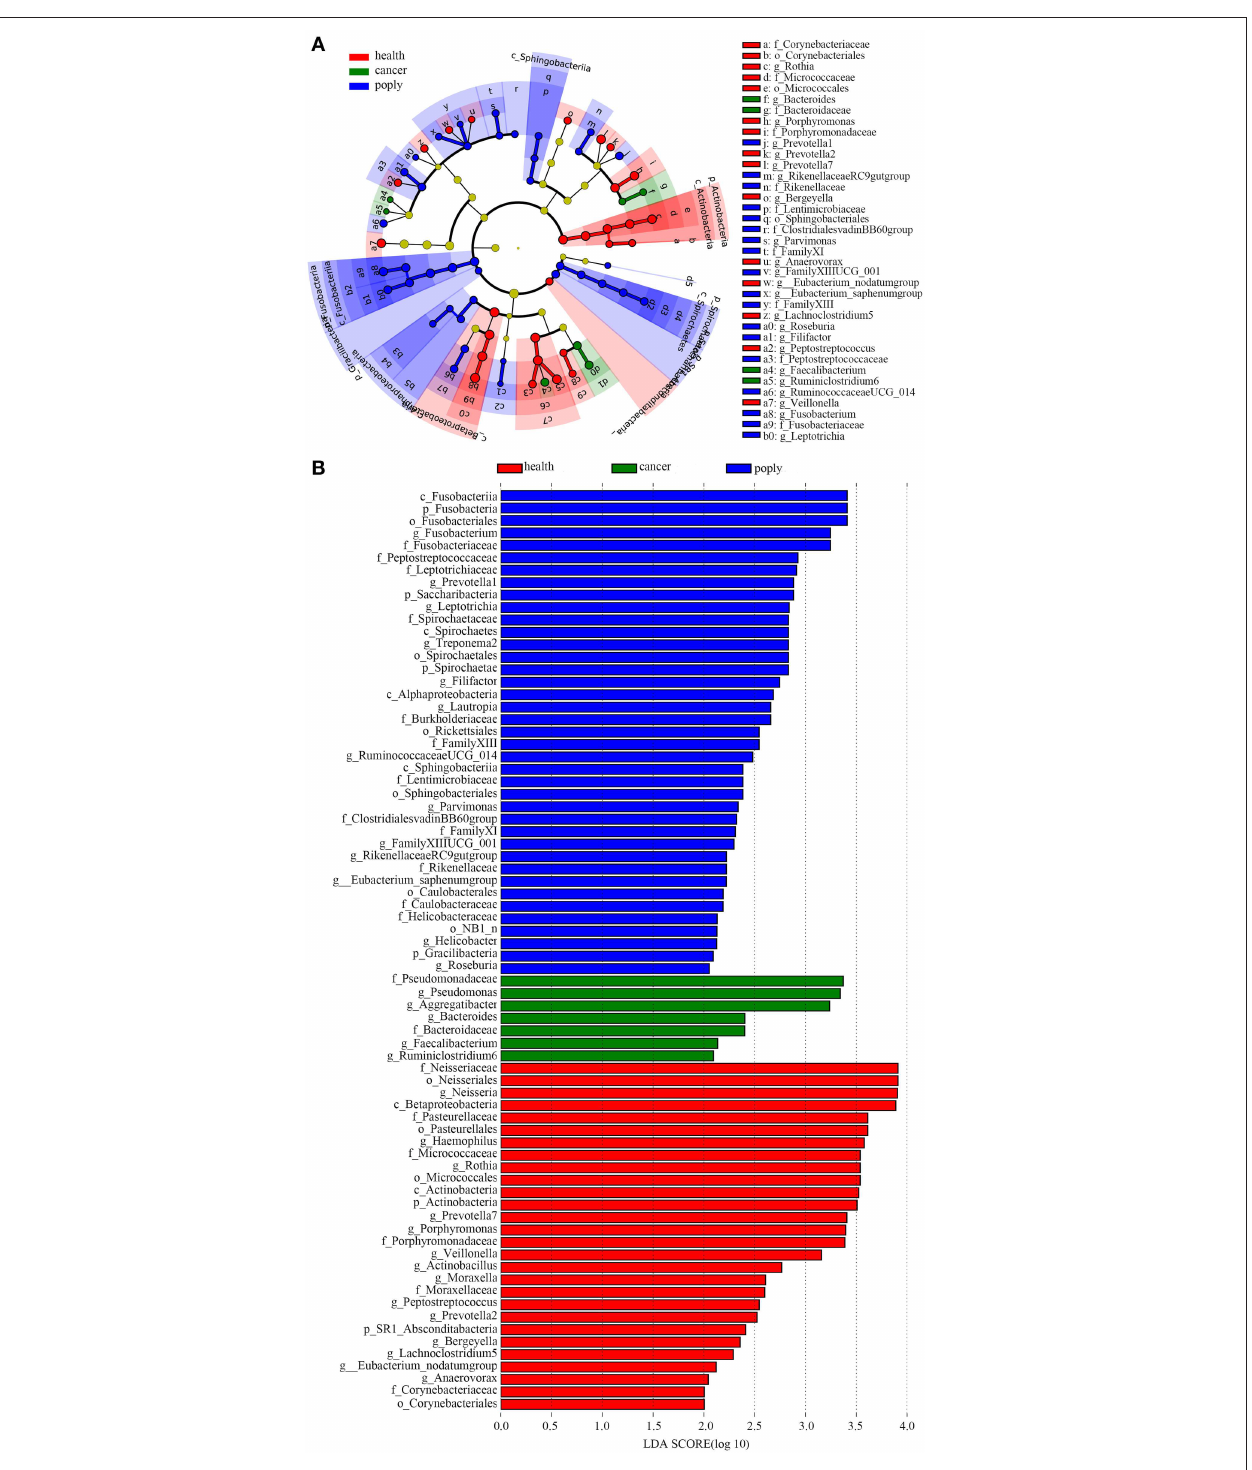
Frontiers in Cellular and Infection Microbiology |